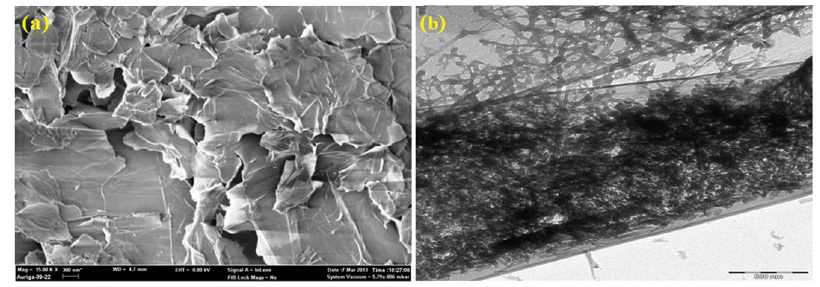
Figure 1. Micrograph of powders. (a) FESEM micrograph of wrinkled top surface of GNPs, (b) TEM of GNPs/CS powder mixture showing the CS particles are well-dispersed throughout the surface area of the graphene sheets.